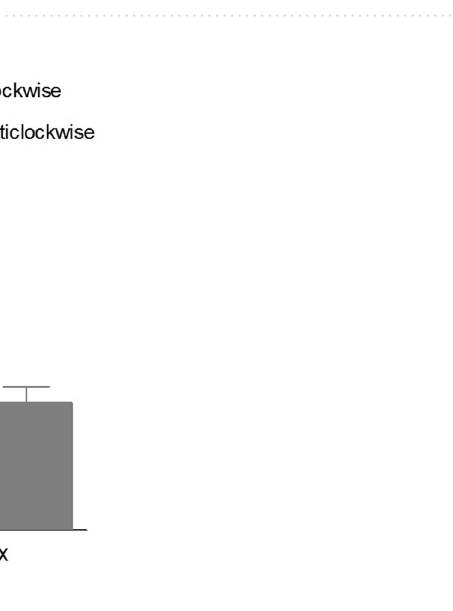
Figure 4. Mean percentage of false alarms as a function of Age (young < 30 years, older > 60 years, Panel A ) and Difficulty (one box and three boxes, Panel B ). Triple asterisk means p -value < .001.